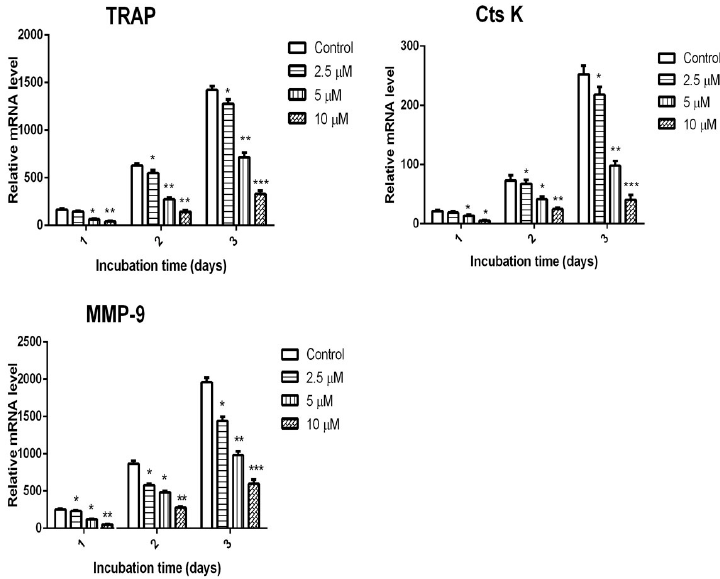
Figure 2. Effects of calycosin on the generation of bone resorption pits. ( a ) BMMs were cultured with indicated dose of calycosin in the presence of M-CSF (20 ng/mL) and RANKL (20 ng/mL) on Corning Osteo Assay Surface 24 well plates. After six days, cells were removed using 5% sodium hypochlorite and staining by Von Kossa method with modified; and ( b ) the areas were quantified by Image J. The results were expressed as means ± SD from three independent experiments. Scale bar represents